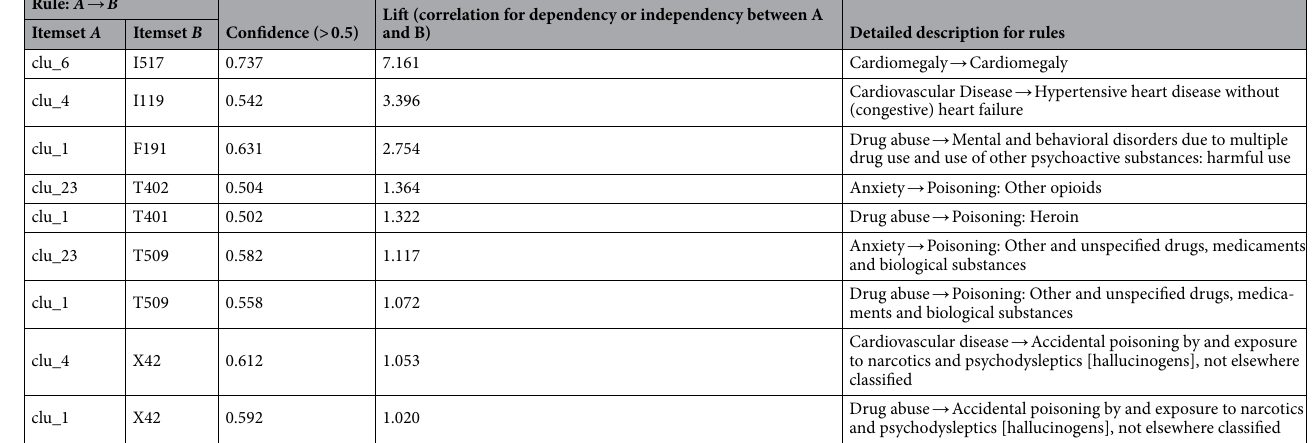
Lift (correlation for dependency or independency between A Confidence (> 0.5) and